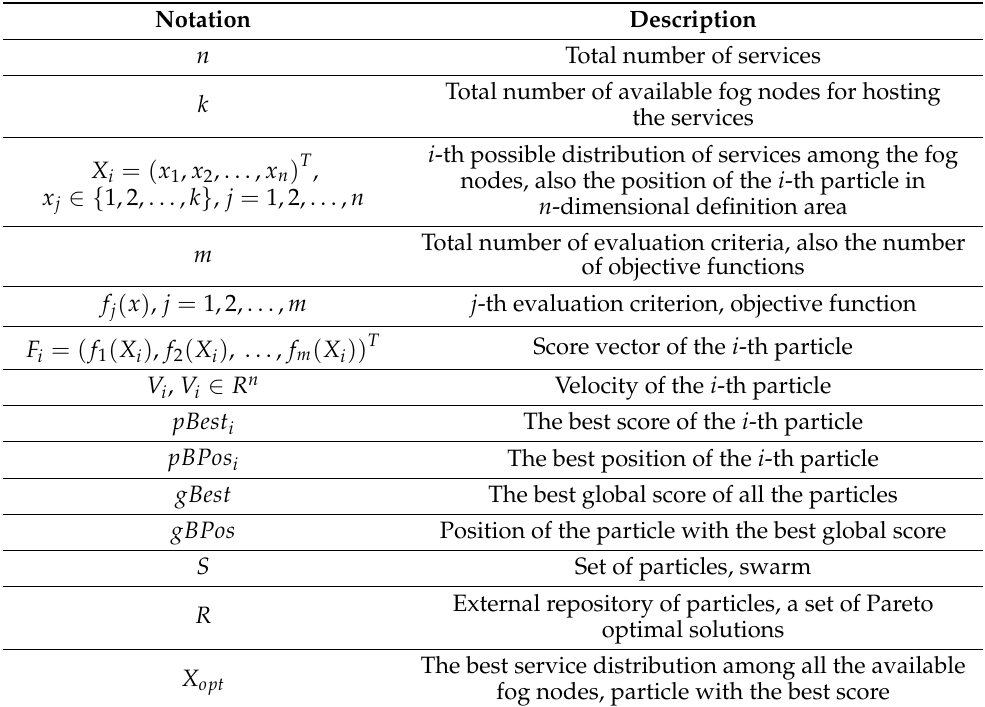
Table 1. Key notations used in this